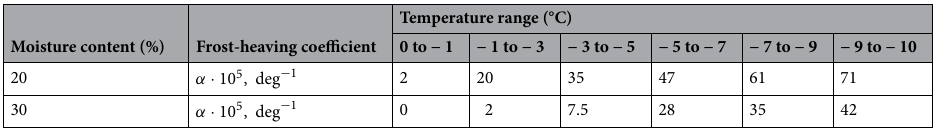
Moisture content